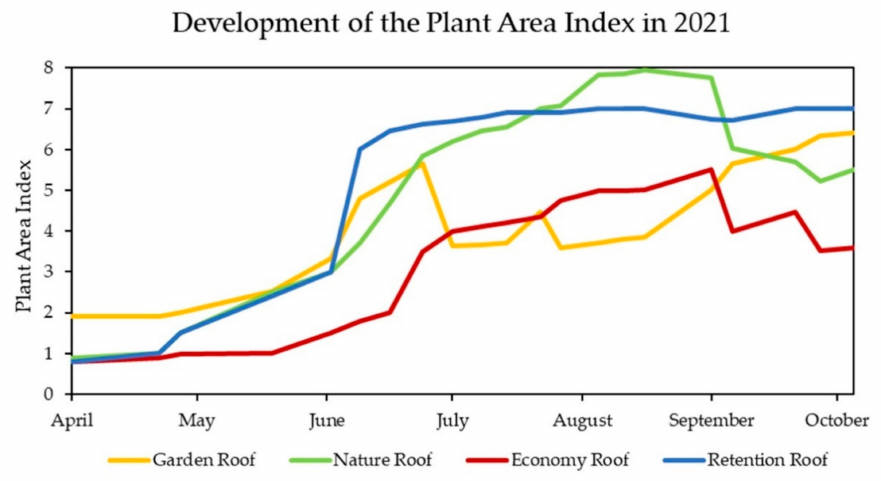
Figure 4. Development of the plant area index of the four different green roofs from April to October